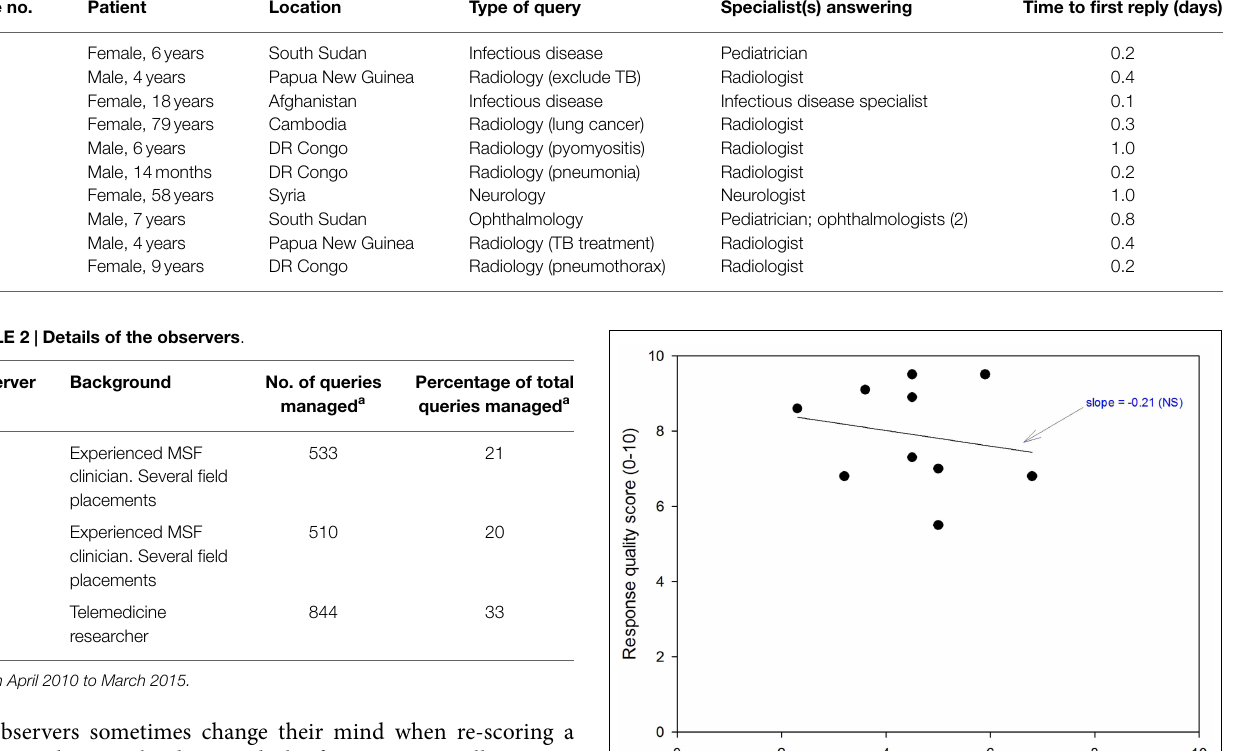
TABLE 1 | Details of the 10 randomly selected cases . Case no.